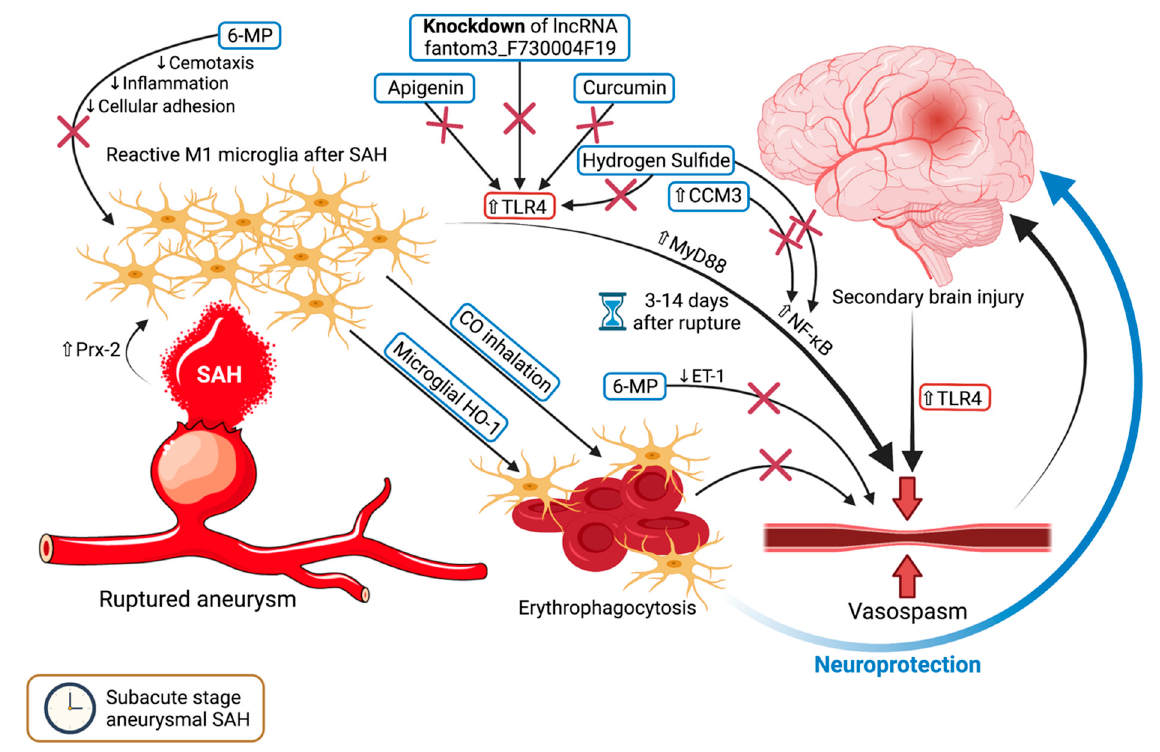
Figure 2. The mechanisms and pathways involving microglia in the subacute stage of subarachnoid hemorrhage (SAH), primarily vasospasm. The reactive M1 microglia that had been stimulated by SAH via Prx-2, in conjunction with the upregulation of TLR4, will result in an anarchic constriction of the cerebral vasculature, aggravating the preexisting brain injury. This occurs between days 3 and 14 after aneurysmal rupture. Certain agents have been shown to suppress the TLR4-dependent pathways by targeting TLR4, namely apigenin, curcumin, hydrogen sulfide, and the knockdown of the long non-coding RNA fantom3_F730004F19. Hydrogen sulfide and CCM3 upregulation also affect a downstream component of the pathophysiological cascade, namely NF- κ B. 6-mercaptopurine restricts vasospasm via endothelin-1 inhibition, while additionally reducing microglial-mediated, inflammation, chemotaxis, and cellular adhesion. CO inhalation and microglial HO-1 stimulate erythrophagocytosis, which in turn alleviates vasospasm and reduces brain damage. A transparent upward-pointing arrow denotes upregulation, whereas a thin downward pointing arrow signifies an inhibition of the mentioned process or protein. Red crosses mark an inhibitory effect. Abbreviations (in alphabetical order): 6-MP, 6-mercaptopurine; CO, carbon monoxide; CCM3, cerebral cavernous malformation 3 gene; ET-1, endothelin 1; HO-1, heme oxygenase isoform 1; lncRNA, long non-coding RNA; MyD88, myeloid differentiation primary response gene 88; NF- κ B, nuclear factor kappa-light-chain-enhancer of activated B cells; Prx-2, peroxiredoxin 2; SAH, subarachnoid hemorrhage; TLR4, toll-like receptor 4.